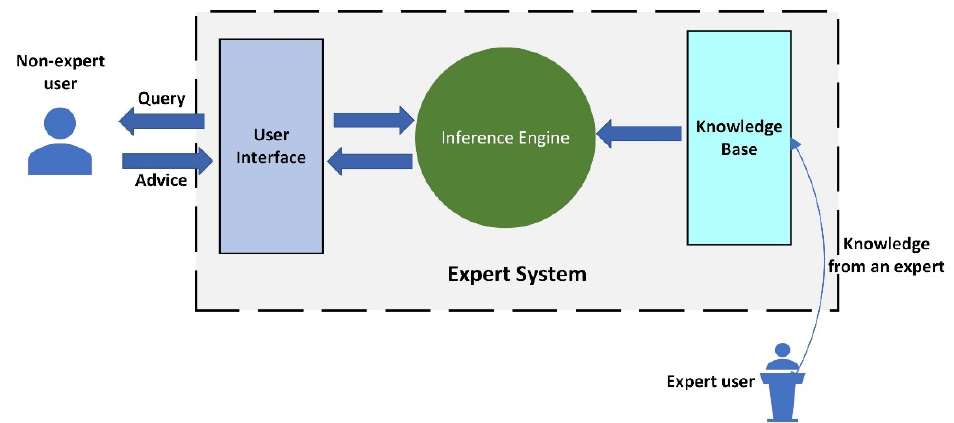
Figure 4. Components or structure of an expert